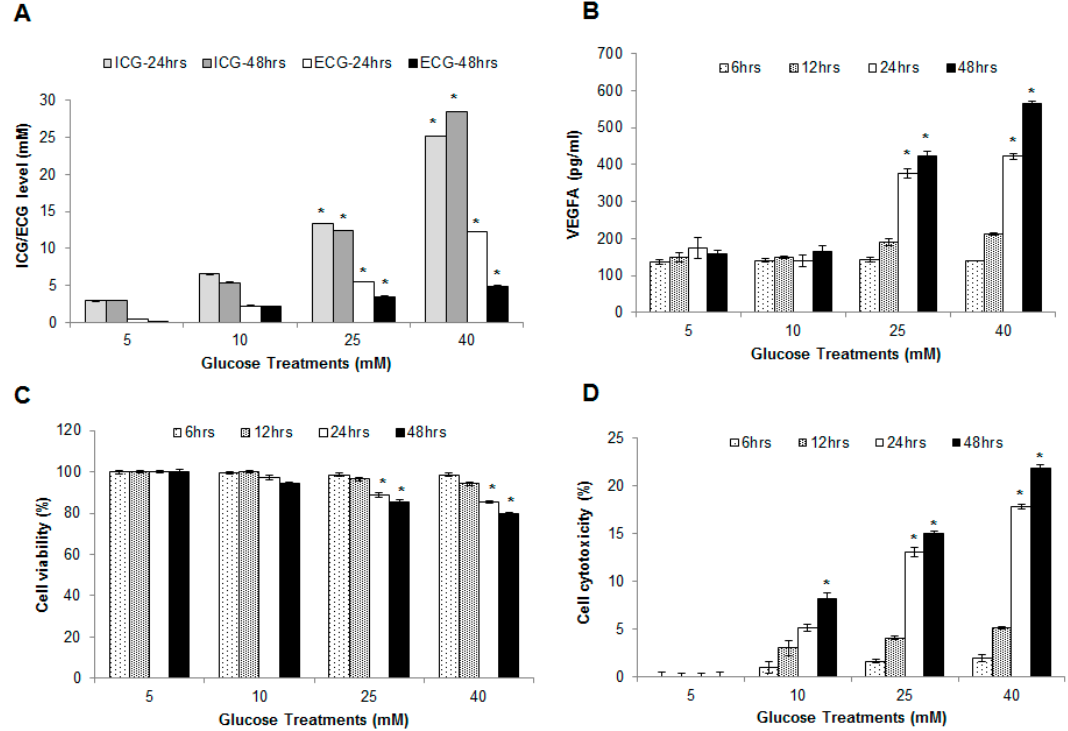
Figure 1. HUVECs subjected to various glucose treatments: ( A ) glucose assay; ( B ) vascular endothelial growth factor A (VEGFA) concentration in culture media; ( C ) cell viability assay; and ( D ) cytotoxicity (LDH) assay. ICG, Intracellular Glucose; ECG, Extracellular Glucose. Cells were treated with various glucose concentrations (5, 10, 25 and 40 mM). Cells and media were collected at 6, 12, 24 and 48 h. Each experiment was carried out in triplicates and as sets of three independent experiments ( n = 3). Data presented as mean ± SEM; * Indicates statistical significance p < 0.05 using student t- test against control (test vs. 5 mM Glucose treatment).